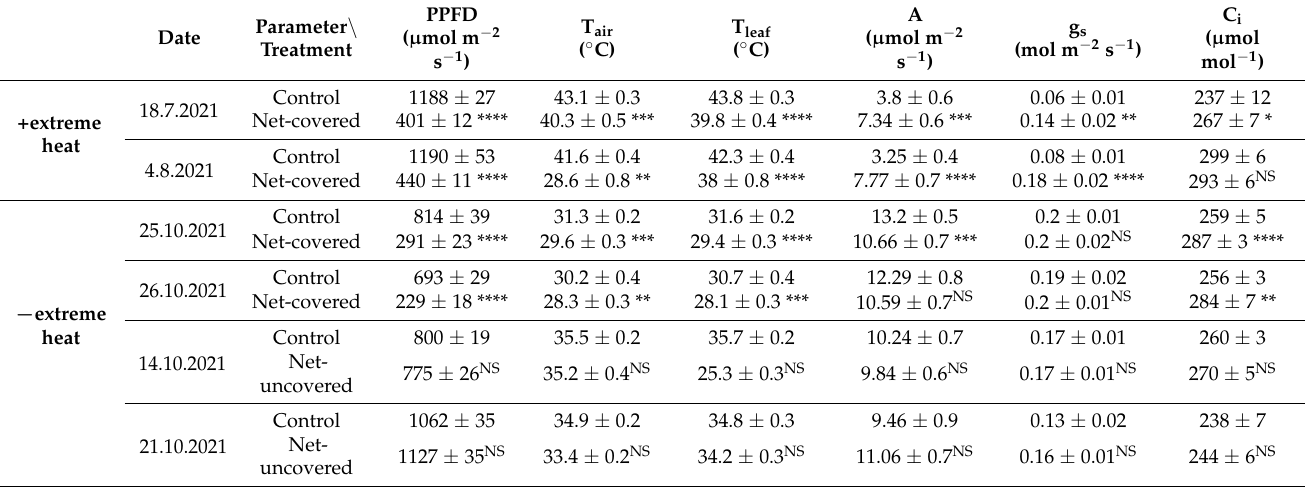
Table 1. Effects of shading nets on solar irradiation incident on the leaves, air and leaf temperatures, CO 2 assimilation, stomatal conductance and sub-stomatal internal CO 2 concentration measured and calculated by the LI-COR system. Parameters were measured in the orchard at midday during an extreme heat event (+extreme heat) when nets were deployed (18 July and 4 August 2021) and under regular fall temperatures (-extreme heat) when nets were deployed (25 and 26 October 2021) or not deployed (14 and 21 October 2021). PPFD—photosynthetic photon flux density; T air —air temperature; T leaf —leaf temperature; A—CO 2 assimilation; g s —stomatal conductance to water vapor; and C i —substomatal internal CO 2 concentration. Measurements were taken from trees that were not covered (control or net-uncovered) or covered with silver 60% shading net (net-covered). Each treatment was replicated three times with four different trees per replicate. Values are means ± SE of 12 trees ( n = 12, at least four different leaves were measured from each tree). Treatments marked with an asterisk differ significantly (unpaired t -test, * p < 0.05; ** p < 0.01; *** p < 0.001; **** p < 0.0001; NS , not